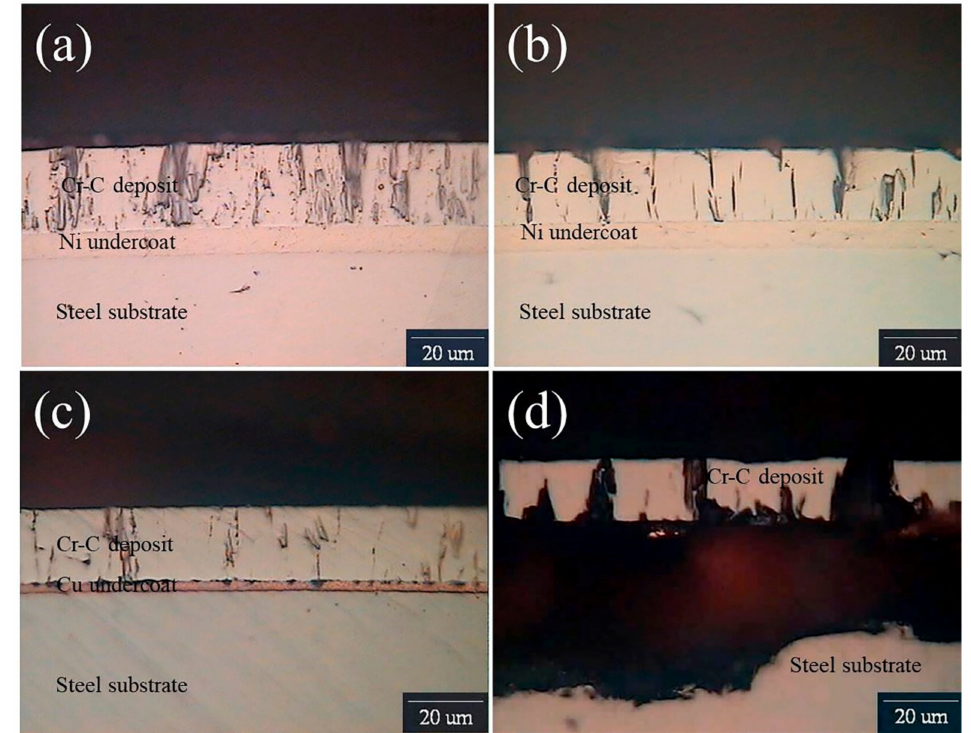
Figure 8. Cross-sectional micrographs of the ( a ) non-heated and ( b ) heat-hardened Cr–C / Ni-coated samples and those of the ( c ) non-heated and ( d ) heat-hardened Cr–C / Cu-coated samples after two-hour potentiostatic etching at 0.5